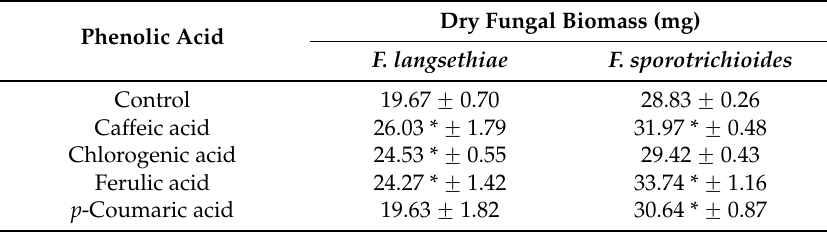
Table 1. Effect of phenolic acids at concentration of 0.5 mM on the dry fungal biomass of cultures incubated at 25 ˝ C for 14 days. Values expressed as mean values ˘ standard deviation (SD) of three biological replications.